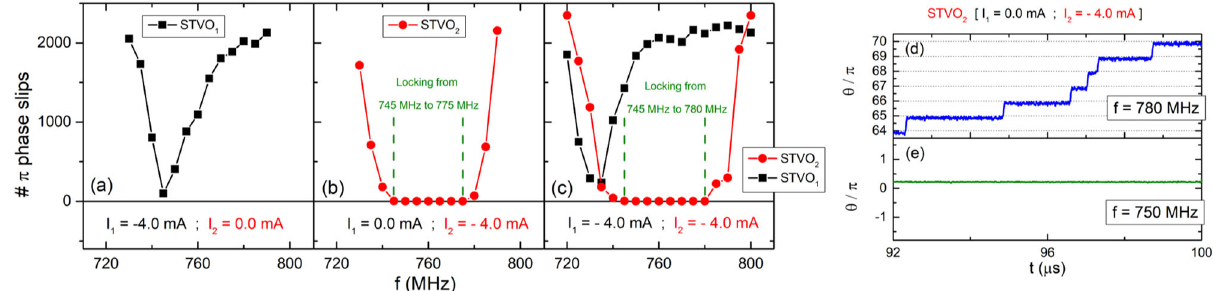
Fig. 5 Second harmonic injection locking of two dipolar-coupled oscillators. The quality of second harmonic injection locking (SHIL) is presented by calculating the number of π phase slips as a function of the frequency of the external signal. The locking is quanti fi ed for ( a ) oscillator 1 (STVO 1 ), ( b ) oscillator 2 (STVO 2 ) and ( c ) both when frequency tuned. Two examples of the phase deviation of STVO 2 are presented for two distinct frequencies of the external signal applied through the fi eld line: ( d ) 780 MHz and ( e ) 750 MHz. These measurements were obtained with a direct current of − 66 mA and a radio-frequency power of 10 mW, both applied through the fi eld